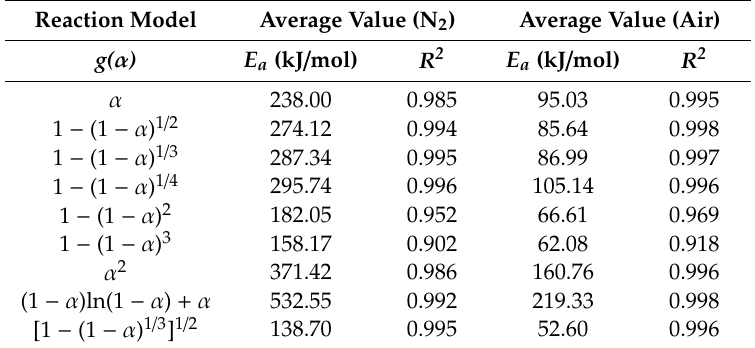
Table 4. The E a values of EPS both in nitrogen and air atmospheres by the Coats–Redfern (CR) method. Reaction